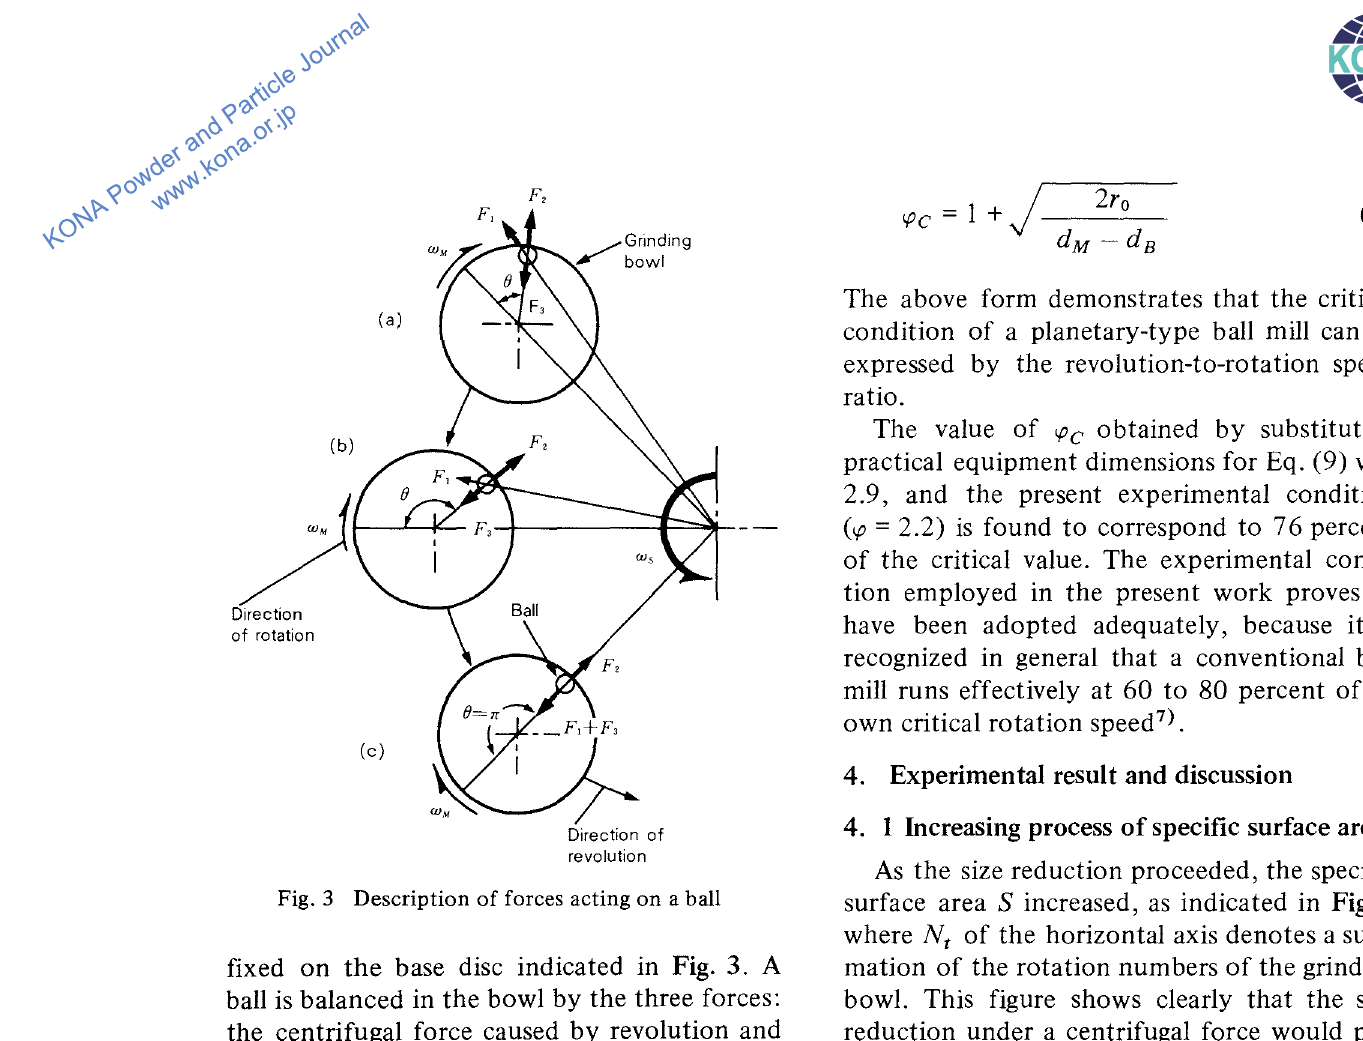
Fig. 3 Description of forces acting on a ball fixed on the base disc indicated in Fig. 3. A